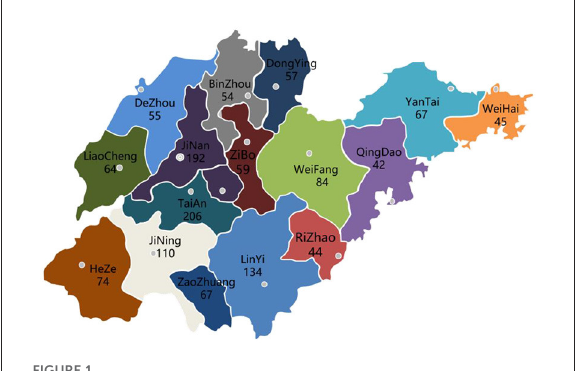
FIGURE1 Map of sample collection and distribution in Shandong Province from 2020 to 2021 (the number represents the number of samples